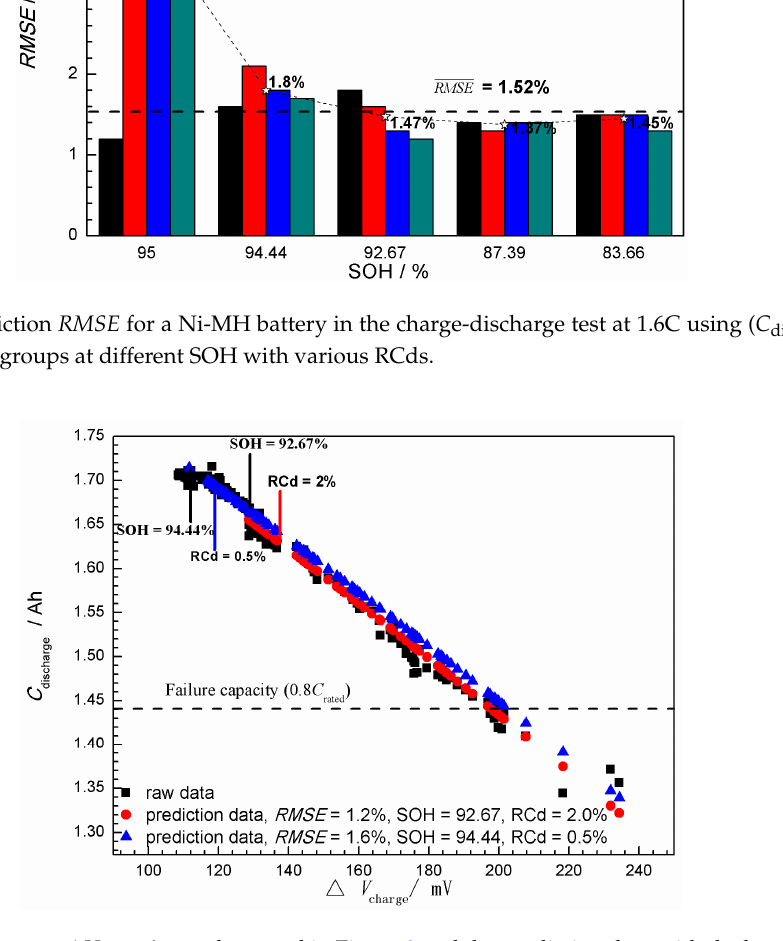
Figure 10. ( C discharge , Δ V charge ) raw data used in Figure 9 and the prediction data with the best RMSE (1.2%) and the RMSE (1.6%) near the RMSE in Figure 9 (1.52%).